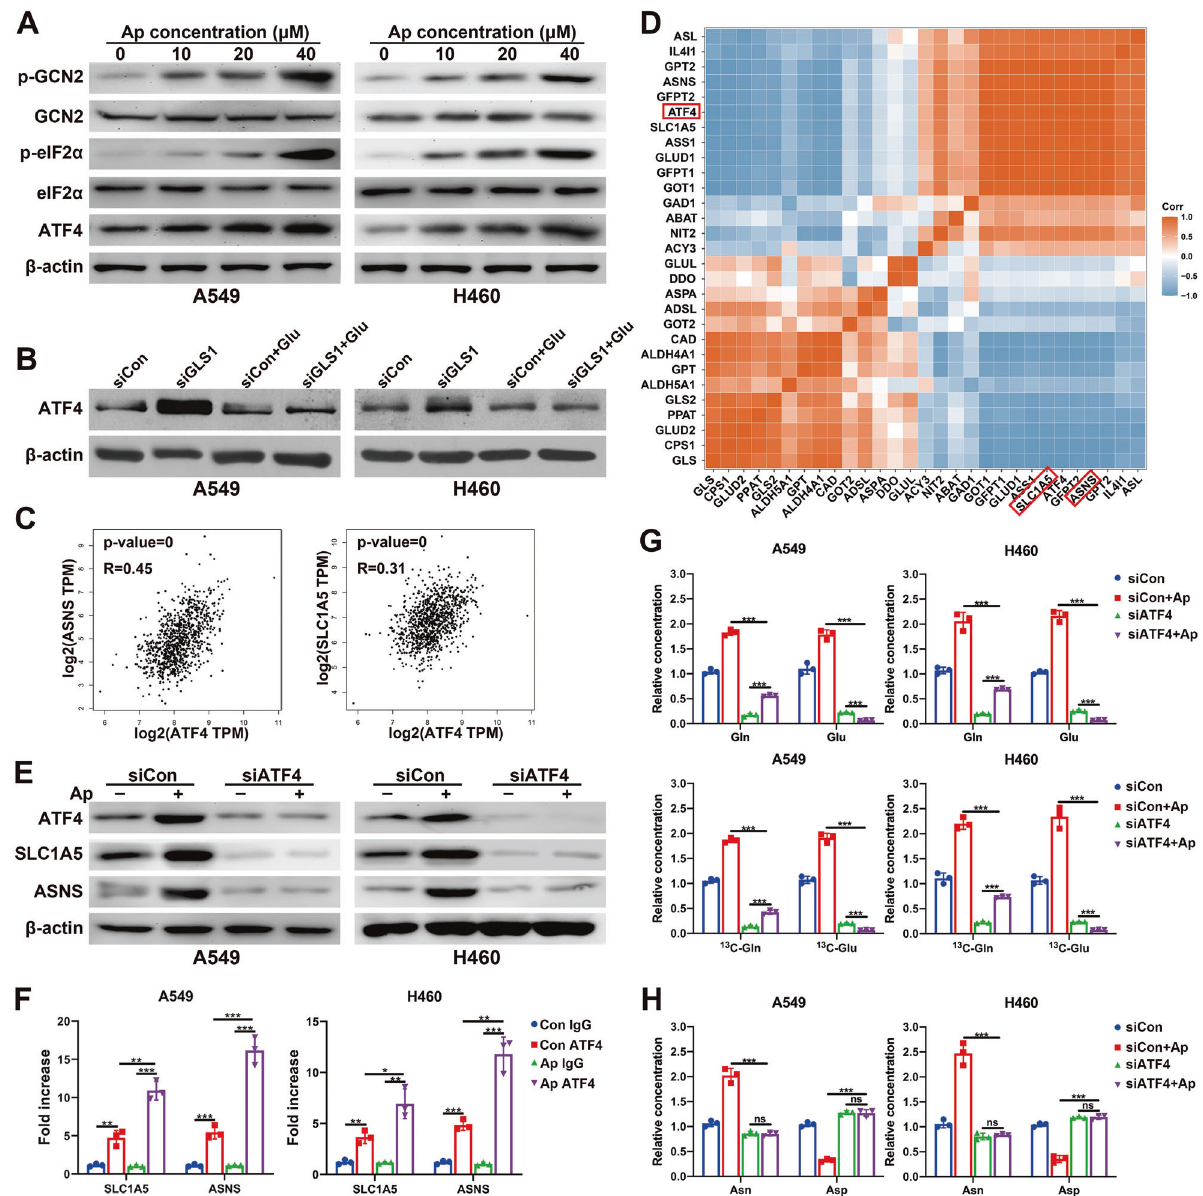
Fig. 5 Apatinib promoted the uptake and catabolism of glutamine via the AAR pathway. A Protein expression of GCN2/eIF2 α /ATF4 pathway genes in A459 and H460 cells incubated with increasing concentrations of apatinib (48 h) was detected by WB. B A549 and H460 cells were treated with or without siGLS1 or exogenous glutamate, and the protein levels of ATF4 were detected by WB. C Scatter plots present the correlations among ASNS (left), SLC1A5 (right), and ATF4 expression in NSCLC patients. D Pearson ’ s coef fi cient in the analysis of the RNA-seq data. E Corresponding cells were treated with or without siATF4 or apatinib, and the protein levels of ATF4, SLC1A5 and ASNS were detected by WB. F ChIP assay validated the binding capacity of ATF4 to the SLC1A5 and ASNS promoters in A459/H460 cells incubated with apatinib (20 μ M, 48 h) or negative control. G LC – MS analysis of the relative intracellular contents of glutamine and glutamate in the control or siATF4 A459/H460 cells incubated with negative control or apatinib (20 μ M, 48 h). H LC – MS analysis of the relative intracellular contents of asparagine and aspartate in control or siATF4 A459/H460 cells incubated with negatve control or apatinib (20 μ M, 48 h). Data are presented as mean ± SEM from three independent concentrations in NSCLC cells. Moreover, exogenous aspartate supplementation could reverse apatinib-induced autophagy (Fig. S9), which suggested that a decrease in aspartate was the main reason why apatinib caused autophagy. As a key factor of the AAR pathway, ATF4 is overexpressed in a variety of solid tumors, suggesting that it plays an important role in tumor progression [20]. ATF4 can be activated when there is a lack of a variety of amino acids, thus making it the core regulator of amino acid metabolism. ATF4 can regulate a variety of amino